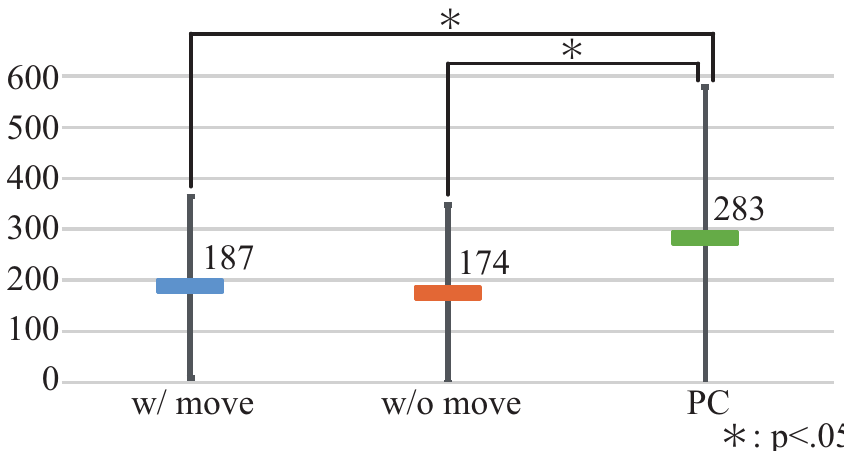
Figure 7. Raw yaw-axis data (P-B).